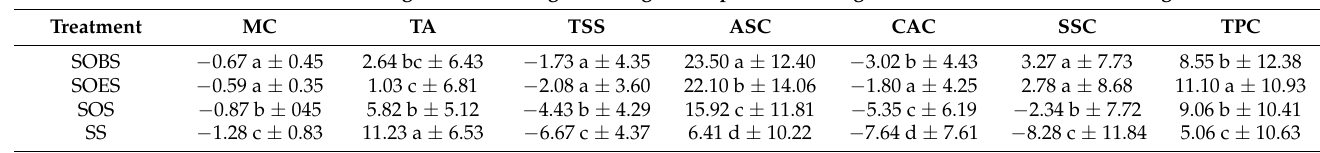
Table 2. Influence of oak leaf powder, oak leaf extract, and biofertilizer on the fruit physicochemical parameters of tomato plants at different stress stages. Increasing and decreasing are labeled by a positive and negative value,